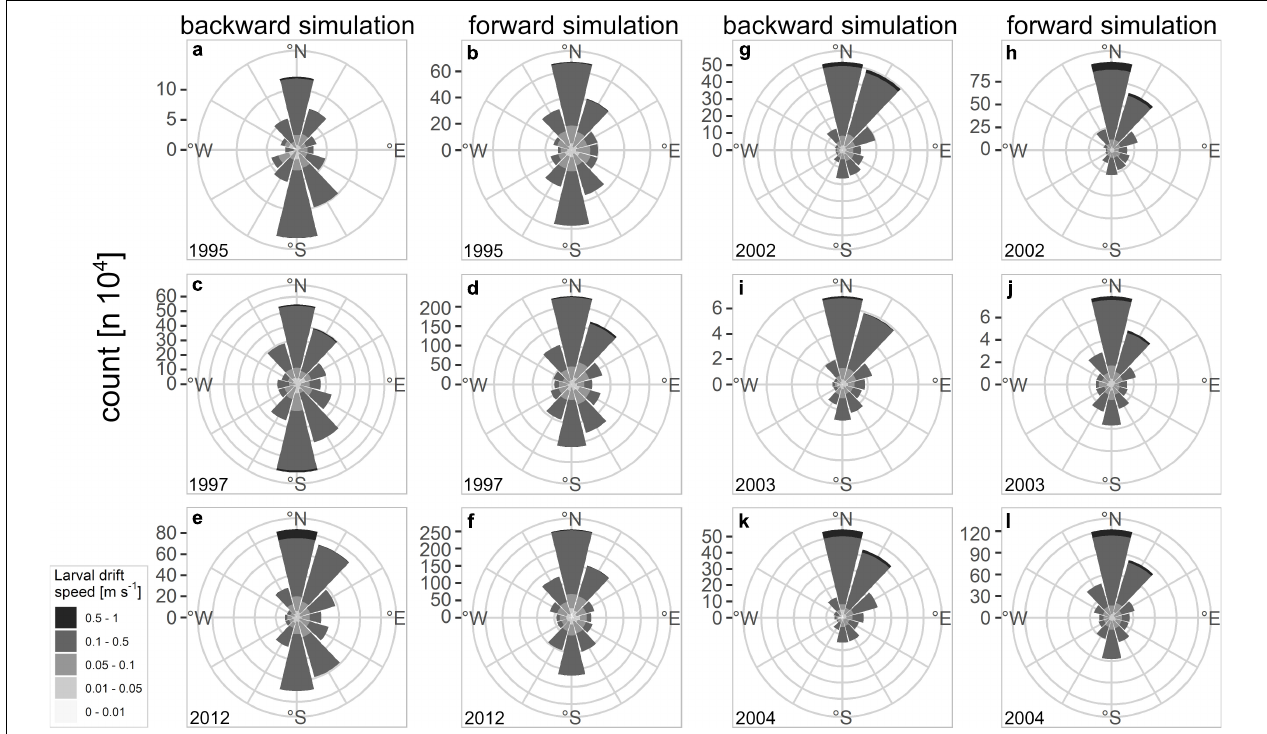
FIGURE 3 | 360 ◦ drift plots of backward and forward simulated larval drift from (a–f) 1995, 1997, 2012, and (g–l) 2002–2004; each bar represents the total amount as count of drift speed and direction the NSS herring larvae were drifting in a certain year.